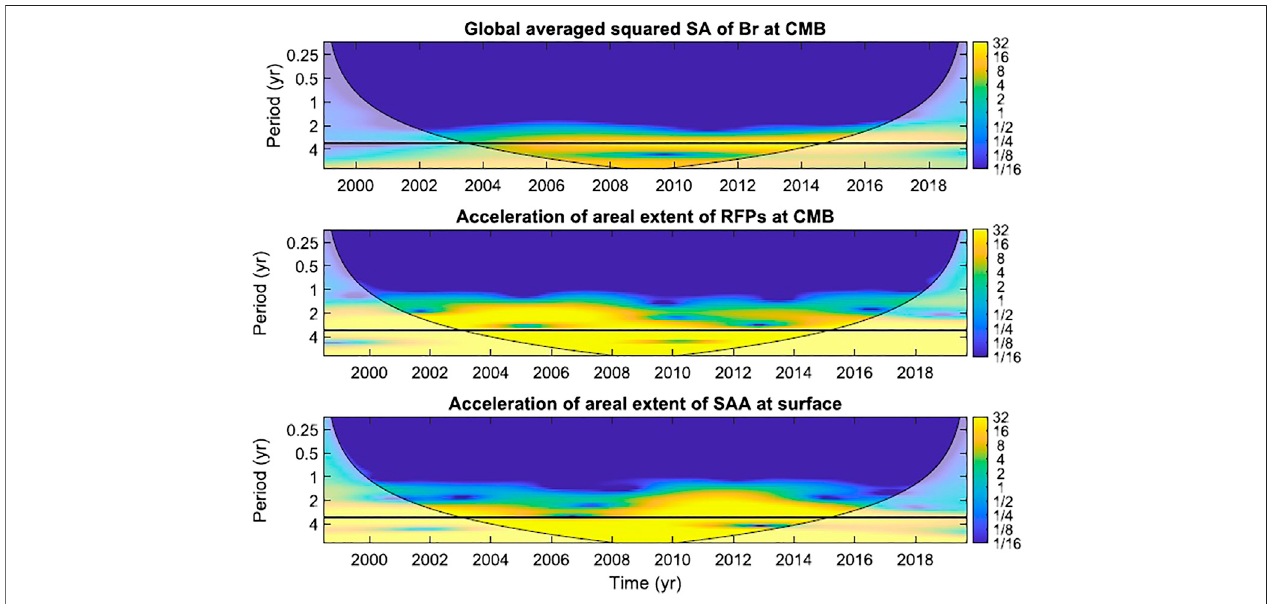
FIGURE 5 | Frequency analysis. Wavelet analysis with Morlet basis functions of (upper panel) the global averaged squared secular acceleration of the radial component (Br) of the geomagnetic fi eld at the CMB, (middle panel) second derivative (acceleration) of the areal extent of the South American and African RFPs, and (bottompanel) thesecondderivative(acceleration)ofthearealextentofSAAforthelast2 decades.Theshadedplotindicatesthenonsigni fi cantpartoftheanalysisand the black lines mark the common period found.